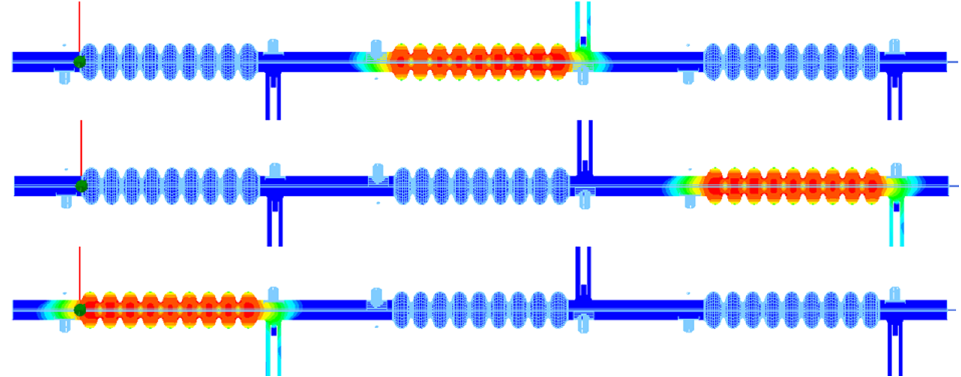
FIG. 8. Operating π mode in the chain of three 3.9 GHz cavities with mechanical errors.